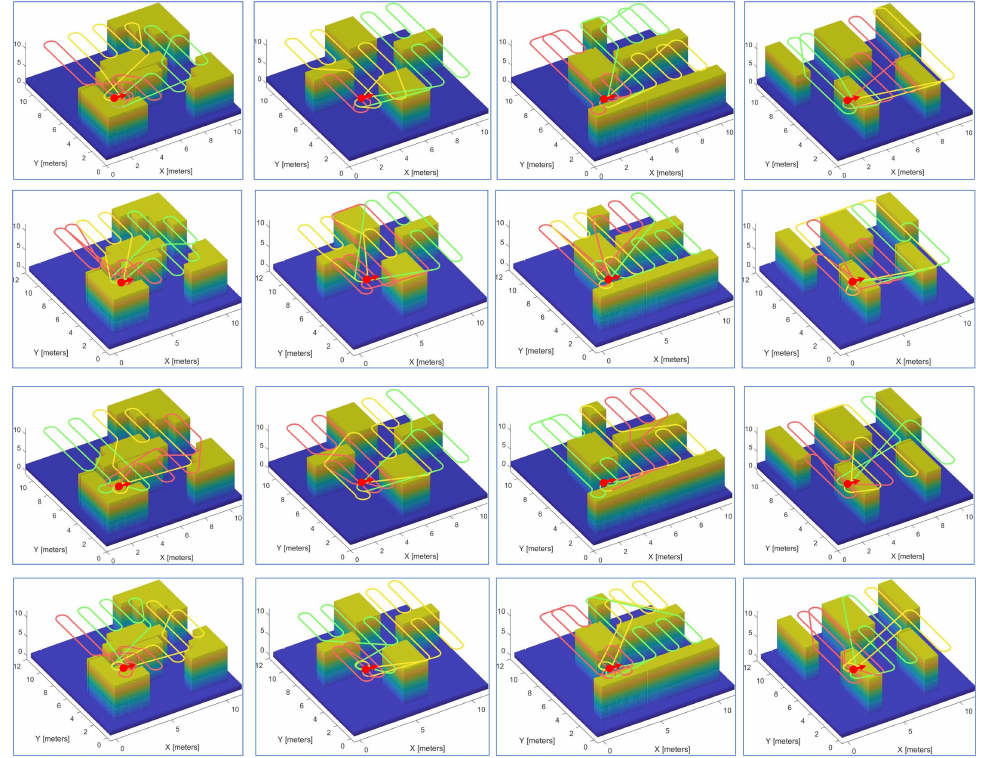
Figure 11. Simulation instances with three robots. The first to fourth rows represent the snapshots of the coverage paths provided by Milpflow [20], DCRC [3], EDM, and CDM,